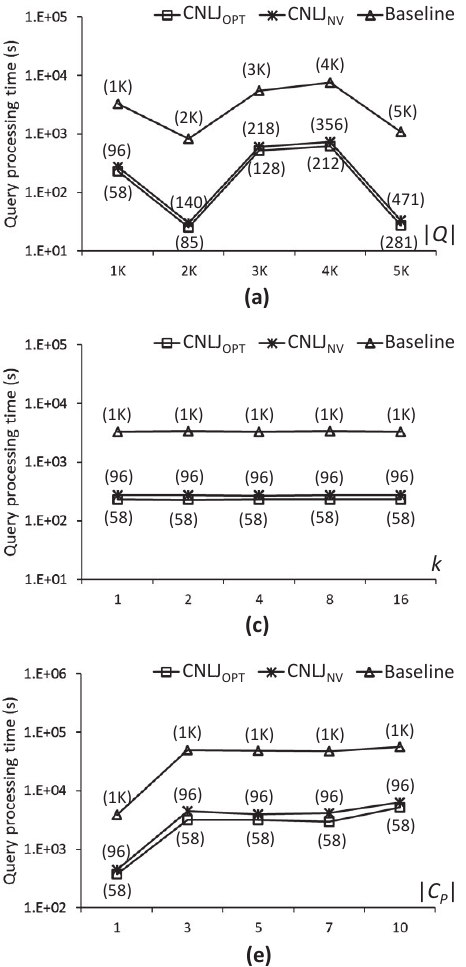
Figure 12. Comparison of k FN join query processing times for the NA roadmap: ( a ) 10 3 ≤ | Q | ≤ 5 × 10 3 ; ( b ) 10 3 ≤ | P | ≤ 5 × 10 3 ; ( c ) 1 ≤ k ≤ 16; ( d ) 1 ≤